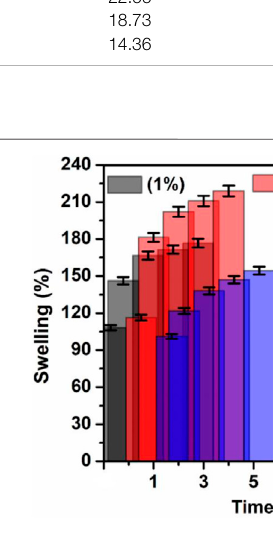
FIGURE 6 | Swelling property of the 1, 2.5, and 5% Lignin@ZnO-GTR